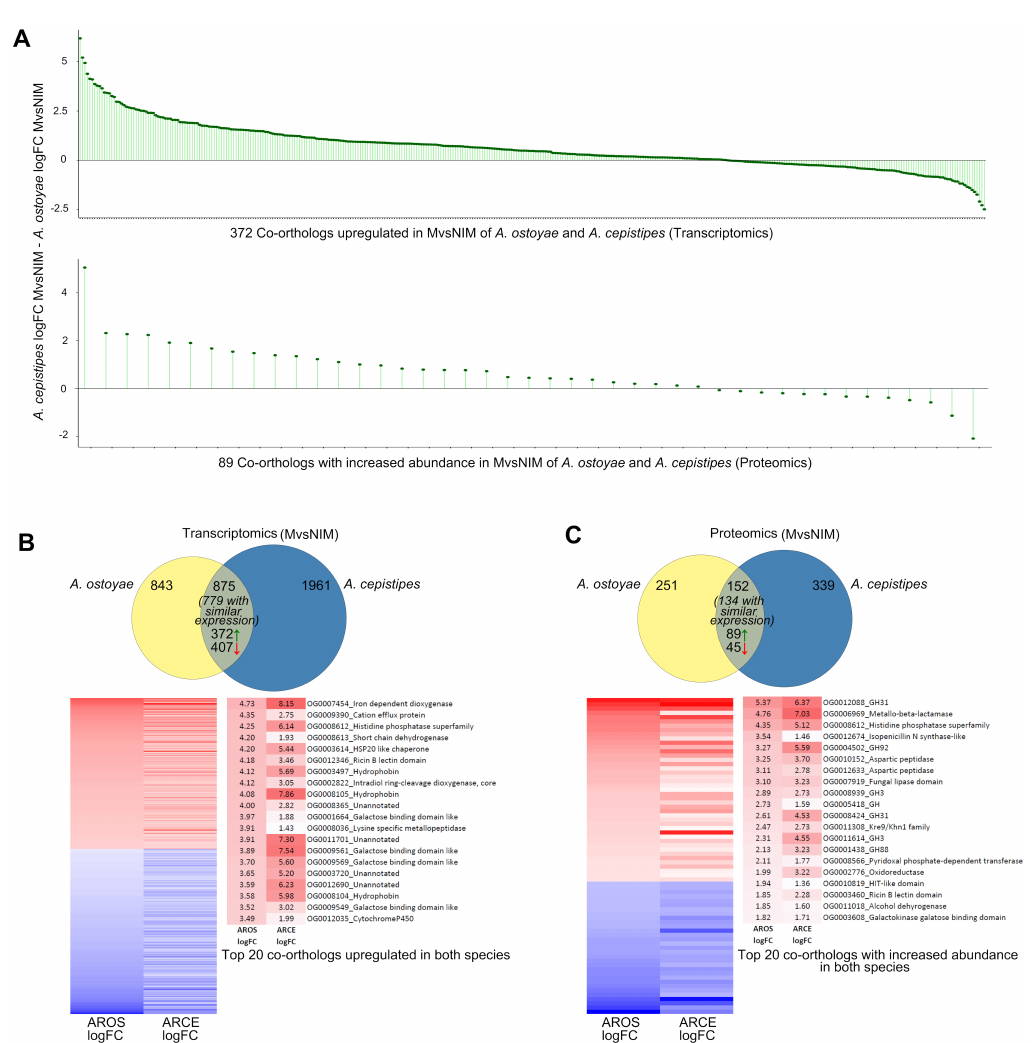
Figure 4. Response towards spruce roots by the mycelia (MvsNIM) of A. ostoyae and A. cepistipes . ( A ) logFC differences of co-orthologs DEG (top) and DAP (bottom) in both species. For proteomics, only genes for which a fold change could be calculated are shown (43 out of 89 orthologs). ( B ) Venn diagram showing species-specific and common DEGs in A. ostoyae and A. cepistipes . Green and red arrows correspond to upregulated and downregulated genes, respectively. Heatmap below shows 779 co-orthologs with similar expression patterns (upregulated/downregulated in both species) out of the 875 common DEGs. Towards right are the top 20 upregulated proteins (red) in the two species, sorted by decreasing logFC in A. ostoyae . ( C ) Venn diagram showing species-specific and common DAPs in A. ostoyae and A. cepistipes . Green and red arrows correspond to proteins with increased and decreased abundance, respectively. Heatmap below shows 134 co-orthologs with similar abundance (increased/decreased in both species) out of the 152 common DAPs. Towards right are the top 20 proteins with increased abundance in the two species, sorted by decreasing logFC in A. ostoyae